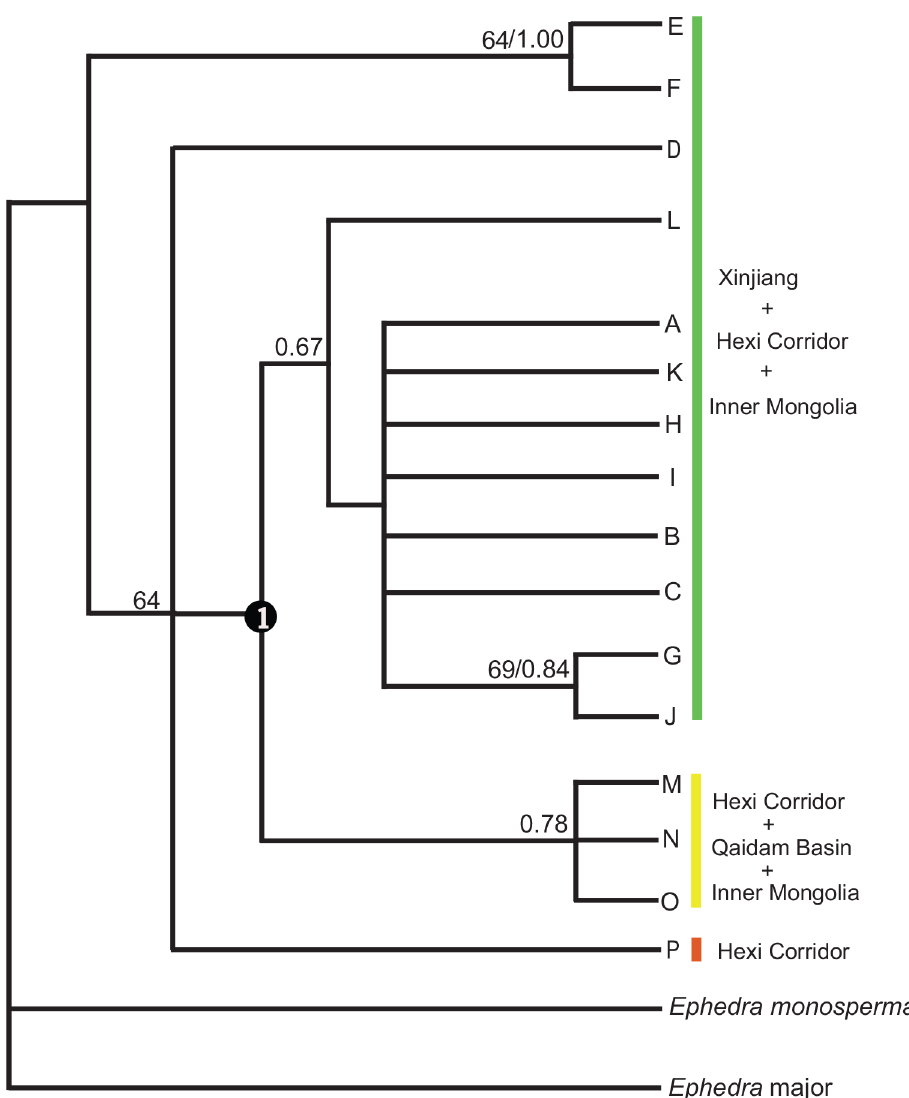
Fig 3. Phylogenetic relationships of 16 haplotypes of Ephedra przewalskii and related species. Numbers above branches are support values (support values > 0.50).